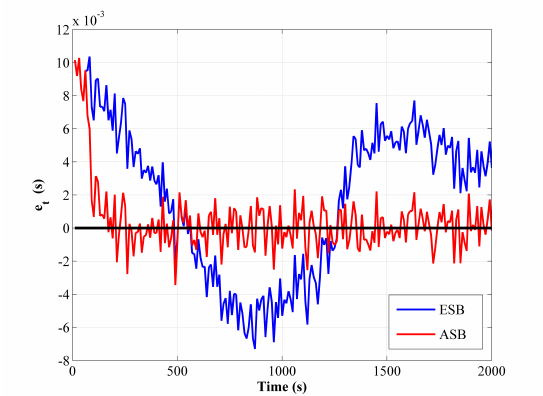
Figure 3. Comparison of transit time measurement innovation between the ESB and the ASB algorithms using simulation data with unknown R k